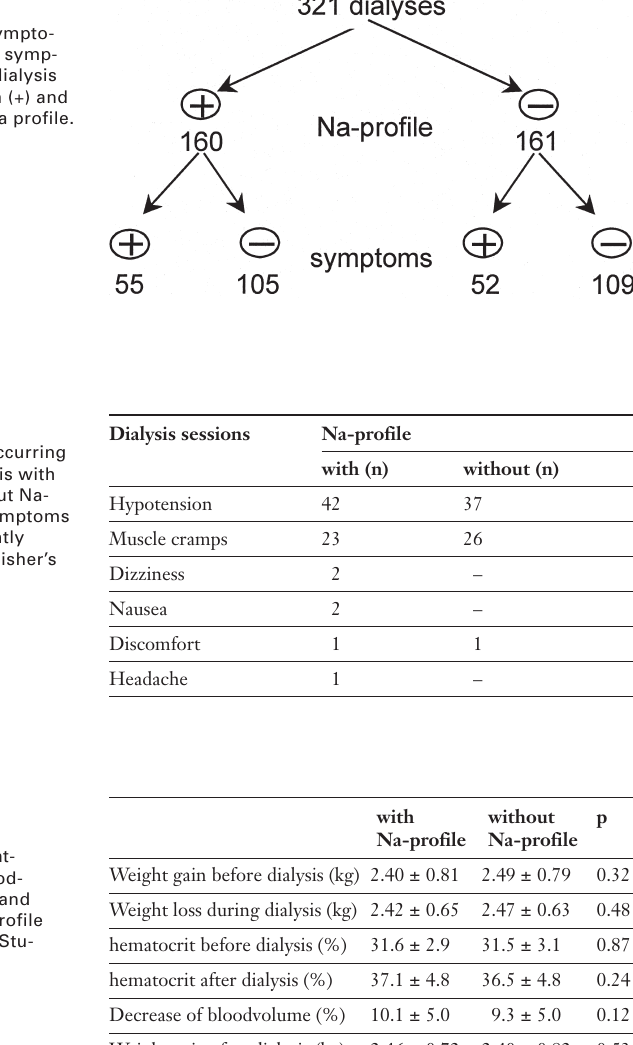
Number of sympto- matic (+) and symp- tom-free (–) dialysis sessions with (+) and without (–) Na profile.